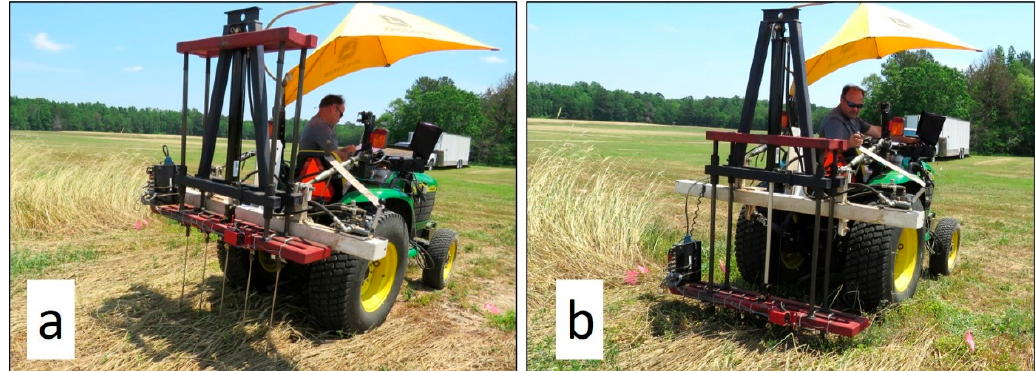
Figure 5. Soil strength measurements by mobile multiple soil cone penetrometer after rolling: ( a ) before inserting into soil; ( b ) fully inserted in soil.